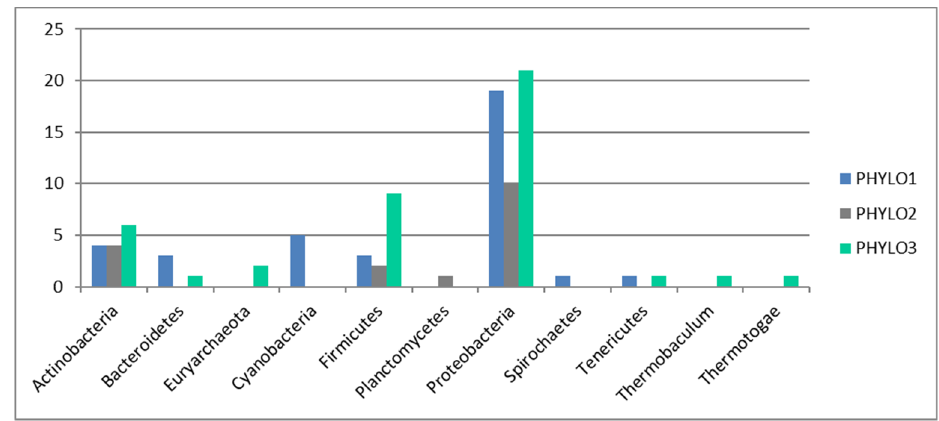
Figure 4. Distribution of taxonomic groups among the three phylogenetic clusters. The data are presented as standardized for the number of genes per bacterial type included in the microarray. Only five (blue, yellow, salmon, midnight blue and light cyan WGCNA modules) of the 21